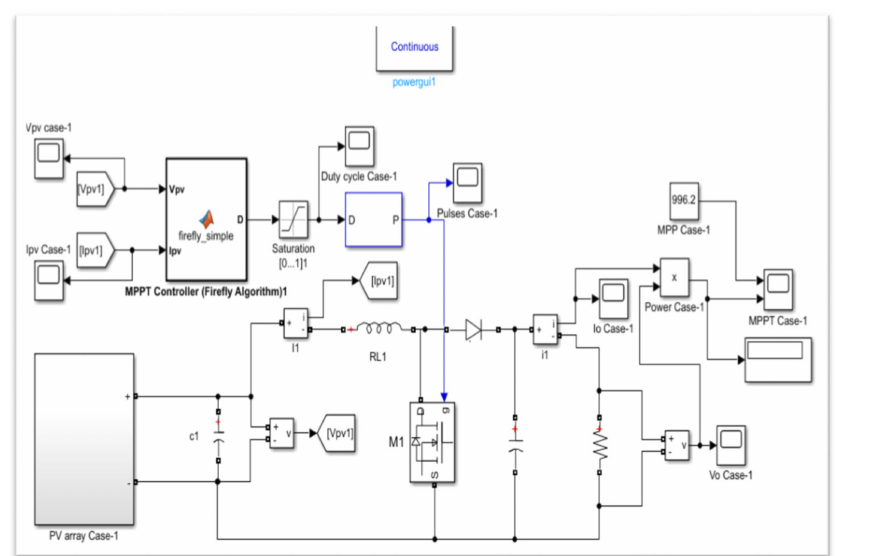
Figure 16. Simulation model of